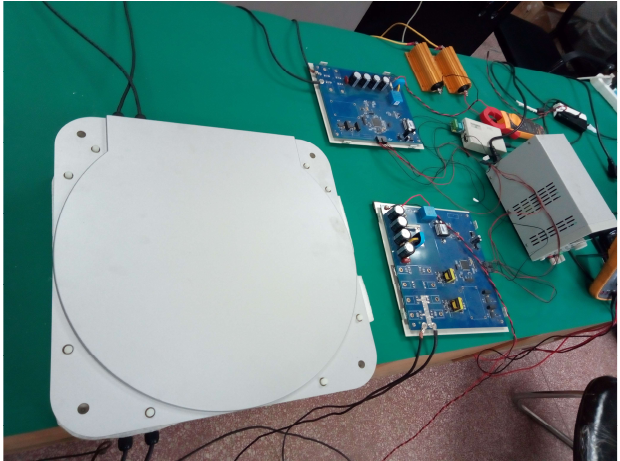
Figure 15. Platform of wireless power transfer system with load adaptive control.